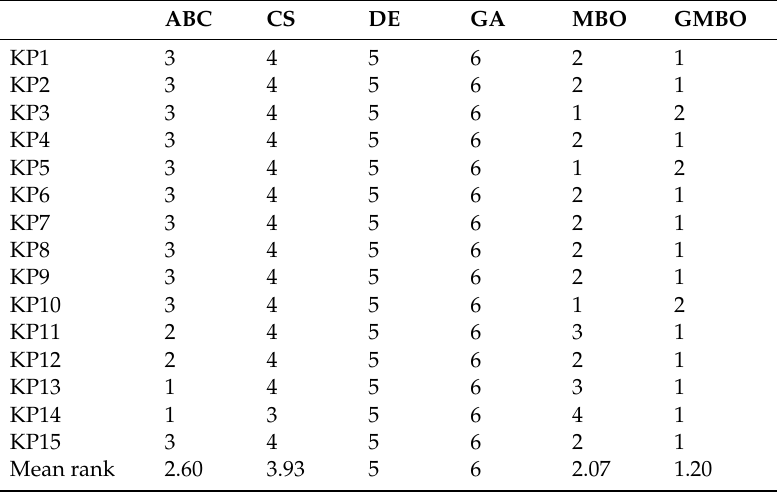
Table 14. Rankings of six algorithms based on the worst